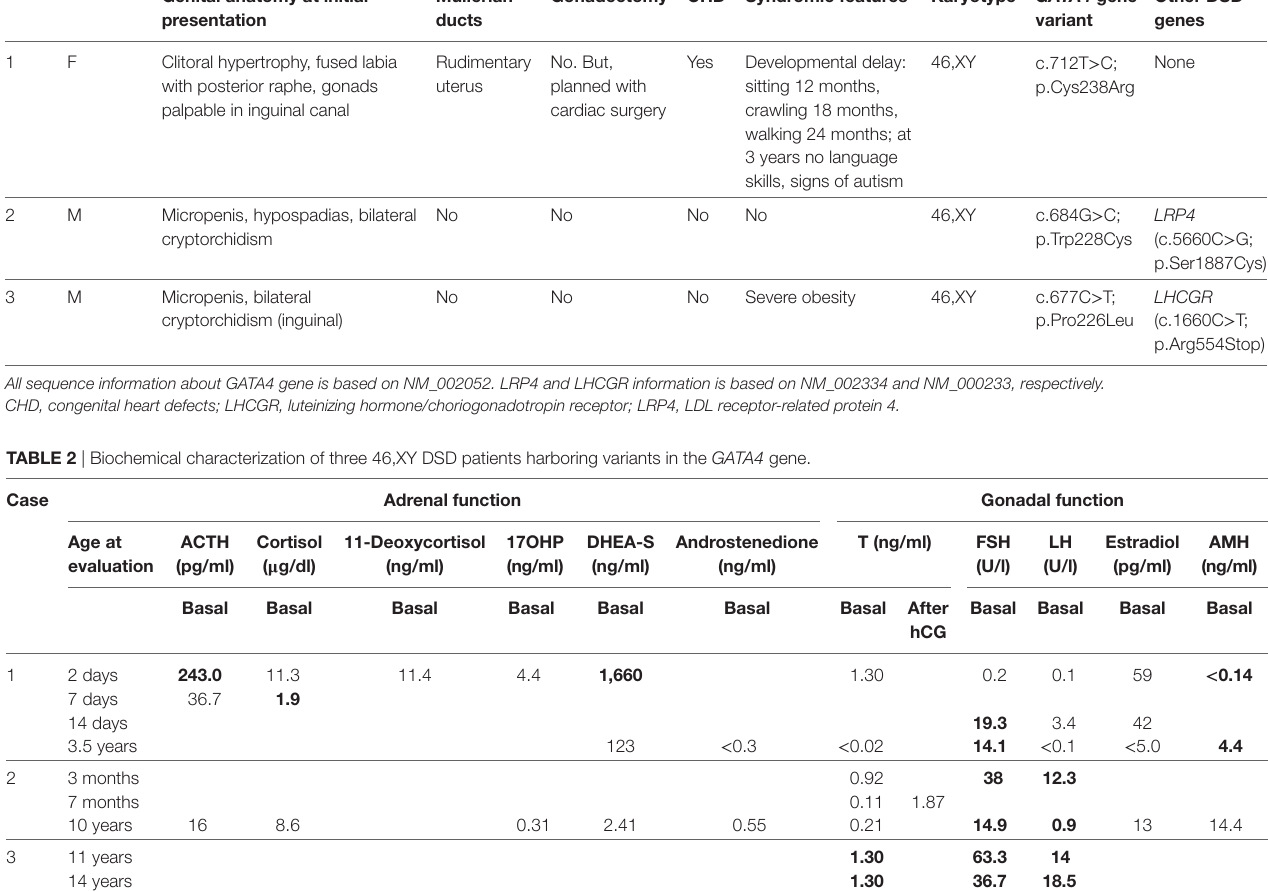
TaBle 1 | Clinical and genetic characterization of three 46,XY DSD patients harboring variants in the GATA4 gene. case gender